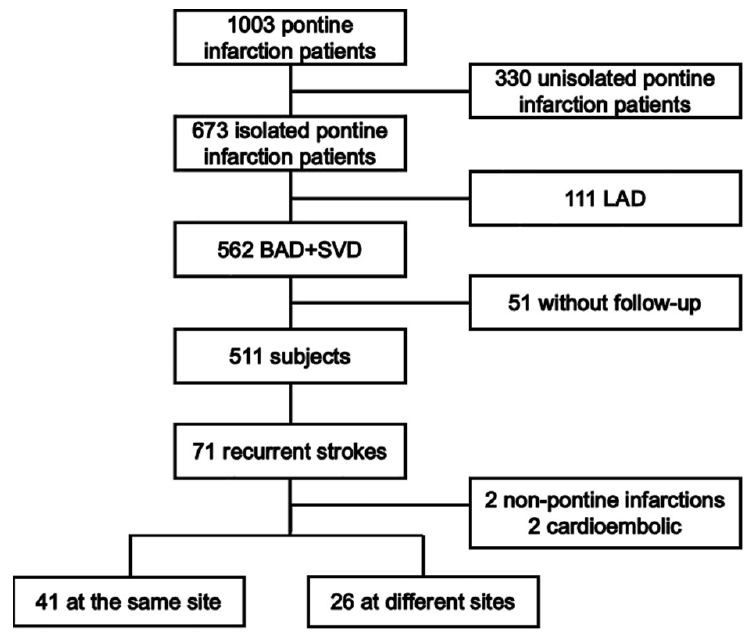
Figure 1. The schematic diagram of the study design.